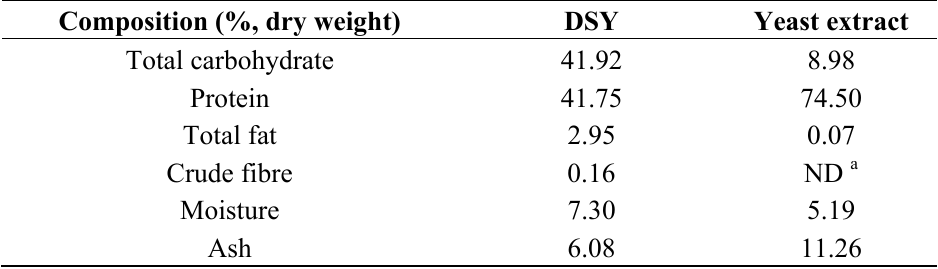
Table 1. The composition of DSY (dried spent yeast) and yeast extract. Composition (%, dry